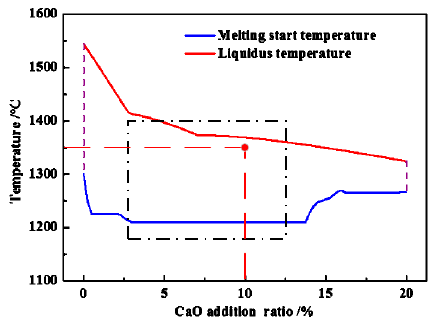
Figure 13. Melting start temperature and liquidus temperature with different CaO addition ratios.